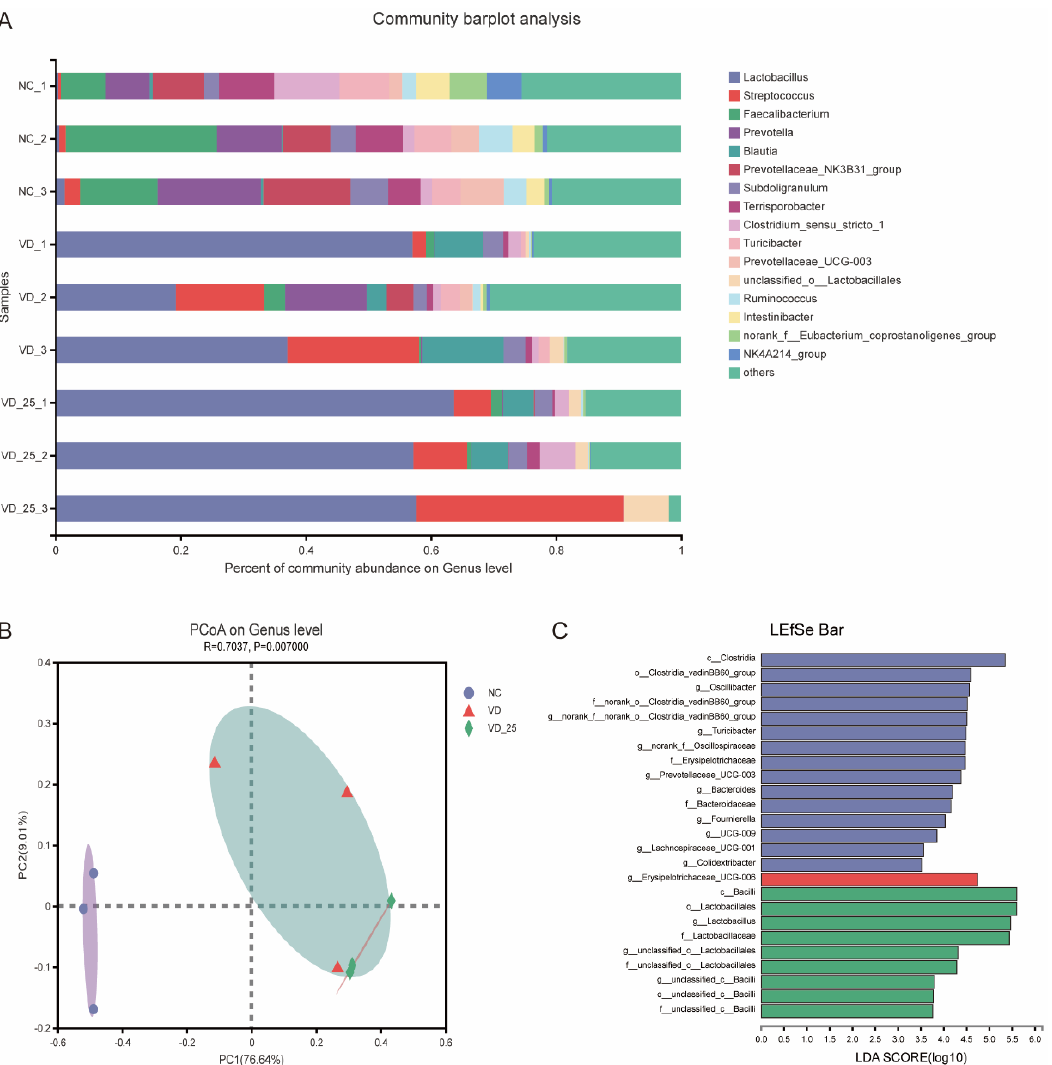
Figure 5. Effect of VD 3 and 25(OH)VD 3 on colonic microorganisms of weaned piglets. ( A ): Microbial composition of colon digesta on genus level. ( B ): PCoA of the microbiome based on weighted Bray– Curtis distance metrics. ( C ): The dominant genus promoted by three diets by LEfSe analysis. n = 3; NC, negative control; VD, vitamin D 3 ; VD_25, 25-hydroxyvitamin D 3 .